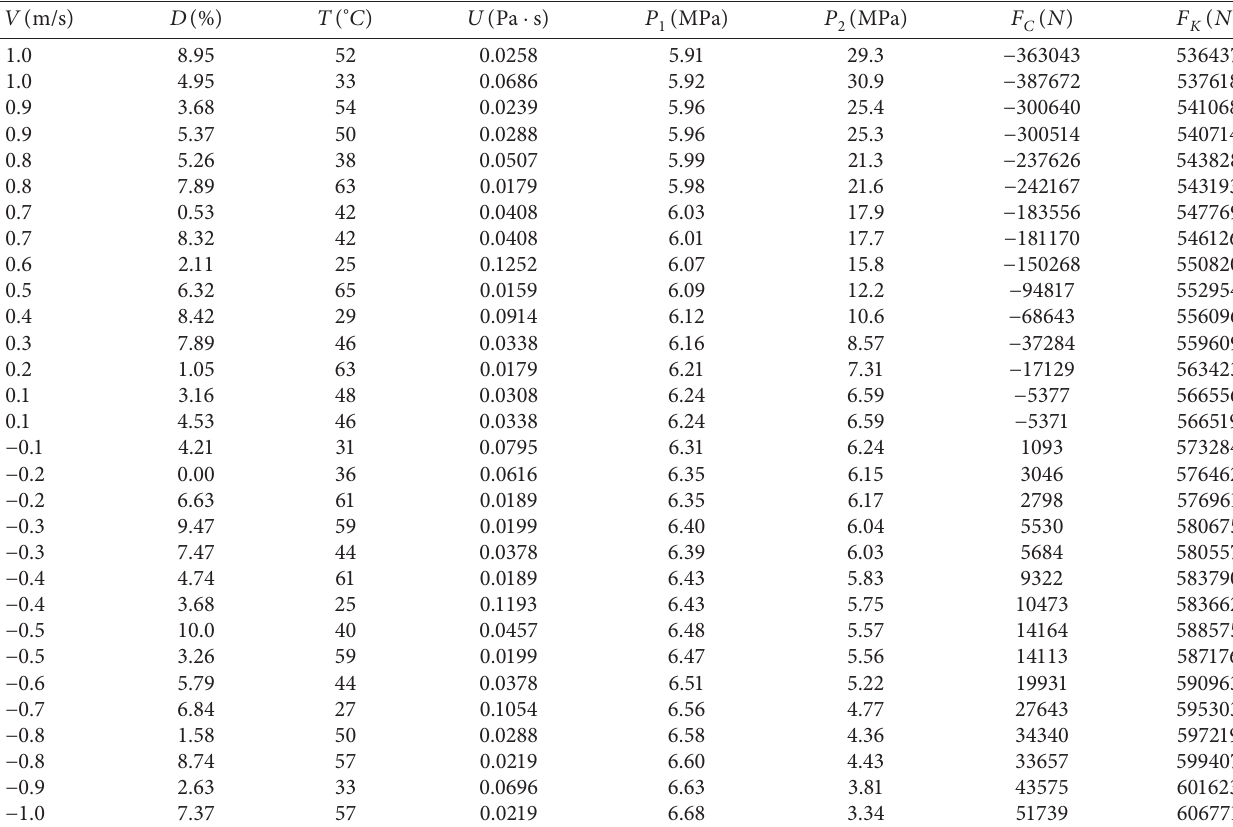
Table 5: Simulation results.